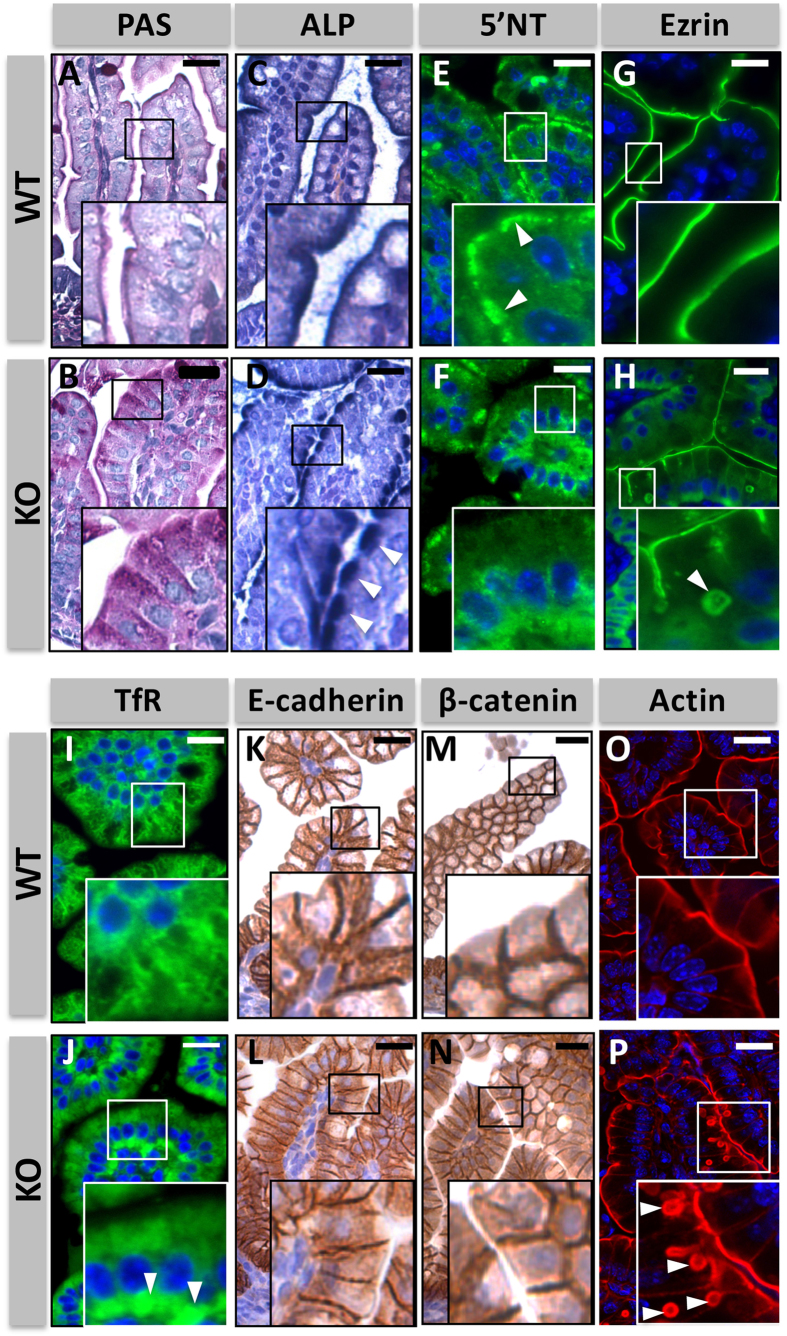
Changes in the localization of apical and basolateral protein markers in Myo5b knockout newborn mice.Periodic acid–Schiff (PAS) staining (A,B), alkaline phosphatase (ALP) staining (C,D; arrowheads indicate the subapical accumulation of ALP in Myo5b knockout mice), immunostaining of 5’-Nucleotidase (5’NT; E,F; arrowheads indicate the apical distribution of 5’NT in wild type mice), ezrin (G,H; arrowhead indicates an intracellular ezrin-coated vesicle in Myo5b knockout mice), transferrin receptor (TfR; I,J; arrowheads indicate the basal accumulation of TfR in Myo5b knockout mice), E-Cadherin (K,L), β-catenin (M,N) and actin (O,P; arrowheads indicate intracellular actin-coated vesicles in Myo5b knockout mice) in Myo5b wild type and knockout newborn mice. Scale bar: 25 μm.